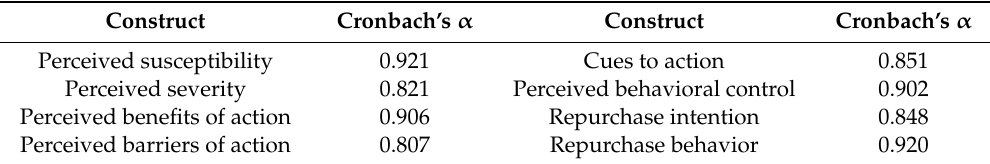
Table 2. Cronbach’s α of